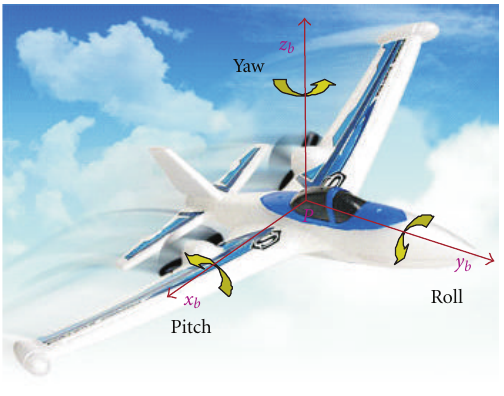
Figure 2: The b -frame illustration and the definition of axis